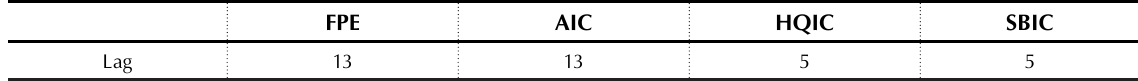
Table 6. Information criteria for lag